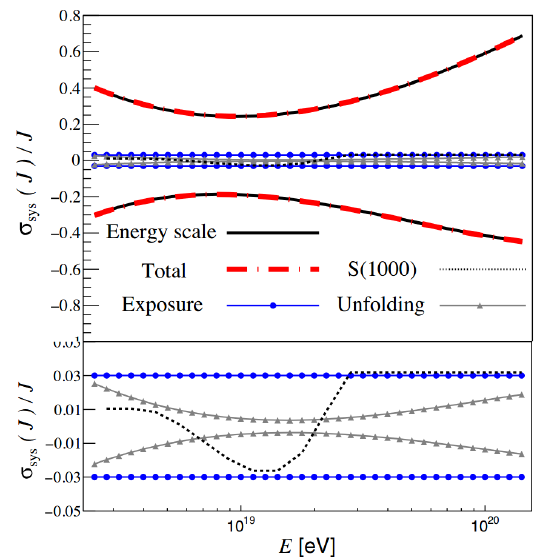
Figure 7. Systematic uncertainties in the energy spectrum as a function of the energy. Contributions from the energy scale, exposure, S (1000) reconstruction, and unfolding procedure are presented. More details can be found in Ref.